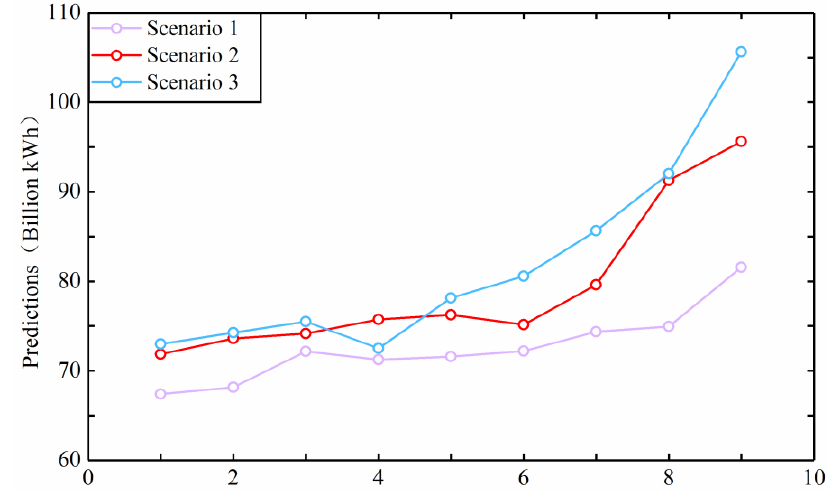
Figure 6. Predictions for wind power generation in different scenarios.